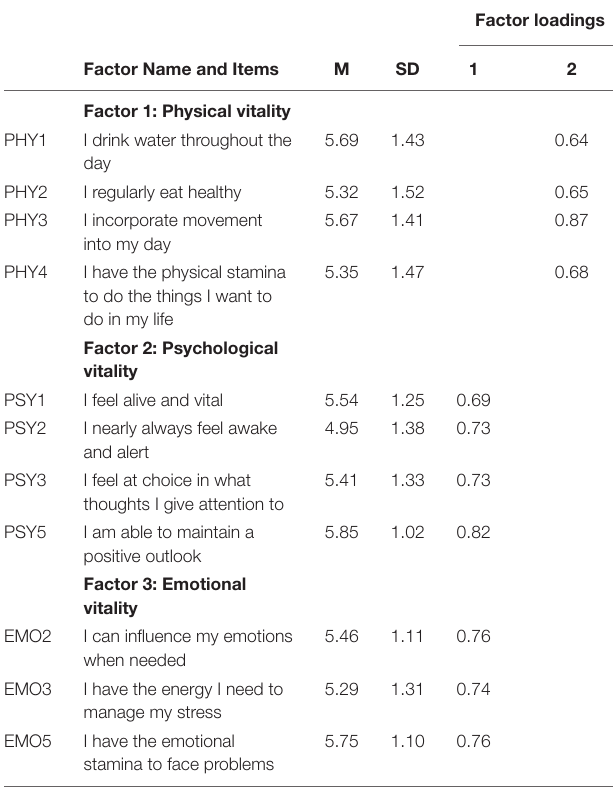
TABLE 2 | Exploratory factor analysis: items, means, standard deviations, and factor loadings of the LVS.